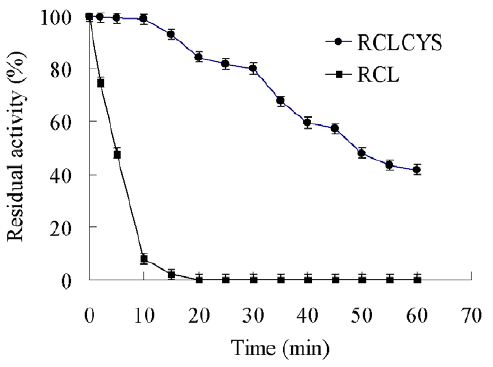
Figure 3. Thermal inactivation of RCLCYS and RCL at 60 6 C.